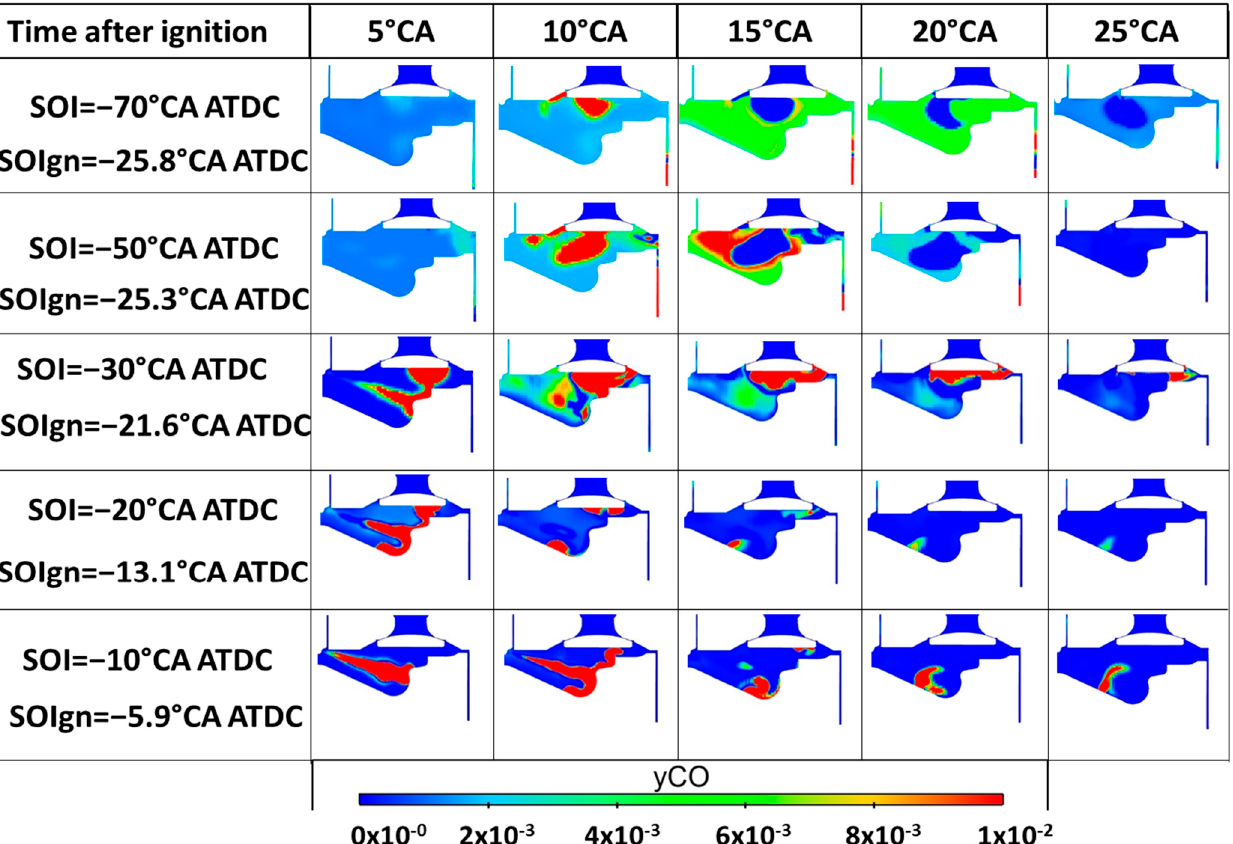
Figure 23. Time histories of CO mass fraction contour plot in a plane formed by the cylinder axis and a spray axis according to °CA after SOIgn for various SOI timings. Table 6. Effects of SOI timing on spray, combustion characteristics, and engine-out emissions.